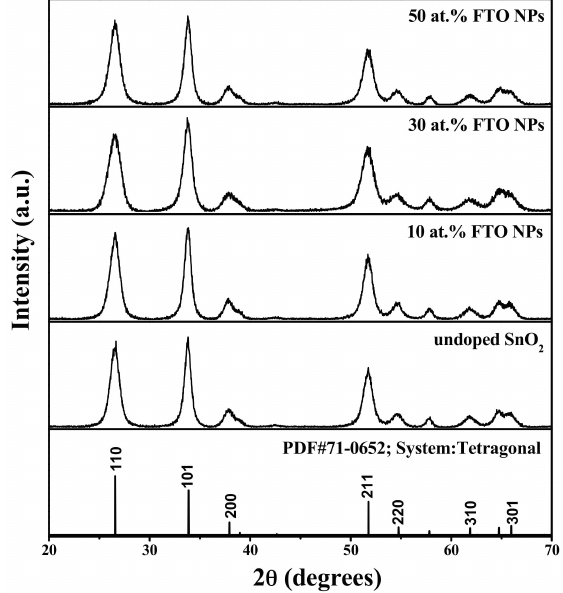
Figure 1. X-ray diffraction (XRD) patterns of tin oxide (SnO 2 ) and F doped SnO 2 (FTO) nanoparticles